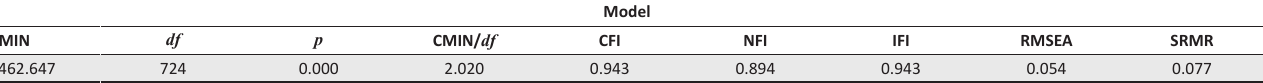
TABLE 4: Fit indicators for confirmatory factor analysis model.